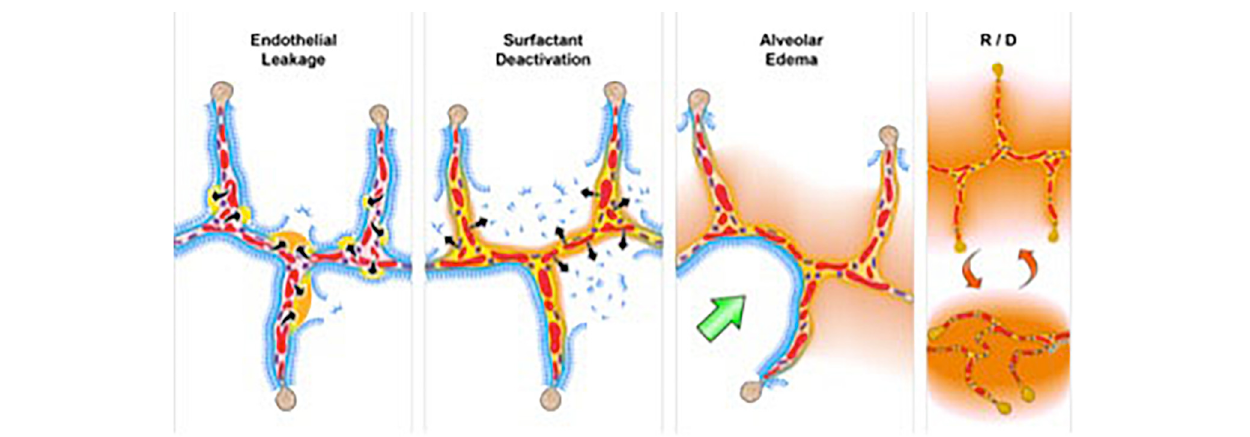
FIGURE 3 | The pathologic tetrad of acute respiratory distress syndrome (ARDS). Alveolar walls contain pulmonary capillaries (red circles) and are lined with a liquid hypophase (blue layer inside each alveolus), with an intact pulmonary surfactant layer (small blue ball with tail) layered on the hypophase. The systemic inflammatory response syndrome (SIRS) secondary to sepsis, trauma, burns, pneumonia, and so on increases pulmonary capillary permeability. Endothelial leakage: increased microvascular permeability allowing pulmonary edema to move into the alveolus (black arrows and tan edema blebs) (Martin and Brigham, 2012). Surfactant deactivation: the continuous layer of pulmonary surfactant molecules is disrupted as the edema blebs expand causing surfactant deactivation (surfactant sluffing off into the alveolar space). Edema usurping surfactant from the alveolar surface, the proteins in the edema fluid deactivating the surfactant (Taeusch et al., 2005), and improper mechanical ventilation (Albert, 2012) causing further surfactant disruption all combine to exacerbate surfactant loss. Alveolar edema: increased capillary permeability (Martin and Brigham, 2012) and high alveolar surface tension combine to flood alveoli with edema fluid (tan). Recruitment / derecruitment ( R / D ): loss of surfactant function results in increased alveolar surface tension causing loss of alveolar stability (i.e., causing alveolar R/D with each breath). Alveoli in the top frame of R/D are fully inflated but collapse during expiration in the bottom R/D frame. Alveolar R/D, known as atelectrauma, is another key VILI mechanism (Cressoni et al., 2017). Stress-focus : edema-filled or collapsed alveoli adjacent to air-filled alveoli create a stress-focus causing the alveolar wall to bend toward the fluid-filled alveolus (green arrow), which can cause stress failure at the alveolar wall (Perlman et al., 2011). Stress-focus is another key mechanism of VILI (Perlman et al., 2011; Chen et al., 2014; Makiyama et al., 2014; Retamal et al., 2014). Thus, the pathologic tetrad sets up a vicious cycle of high microvascular permeability → edema → surfactant deactivation → high alveolar surface tension → more edema → alveolar R/D → further increase in microvascular permeability → severe ARDS (Nieman and Bredenberg,